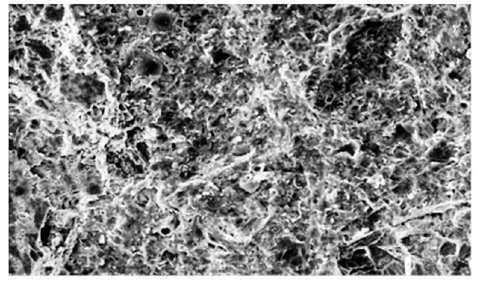
Figure 4. Image noise reduction.